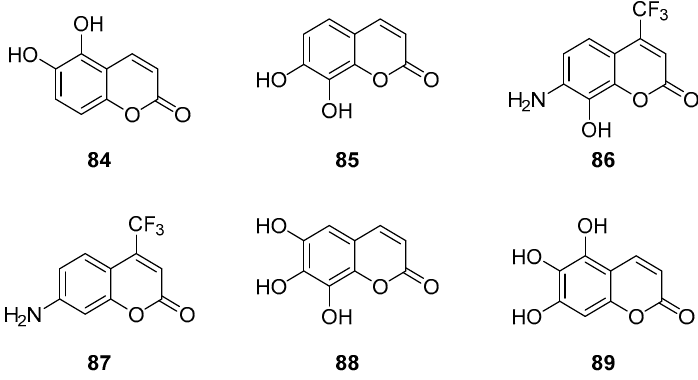
Figure 32. Antiviral coumarins from Bizzarri et al. [129].